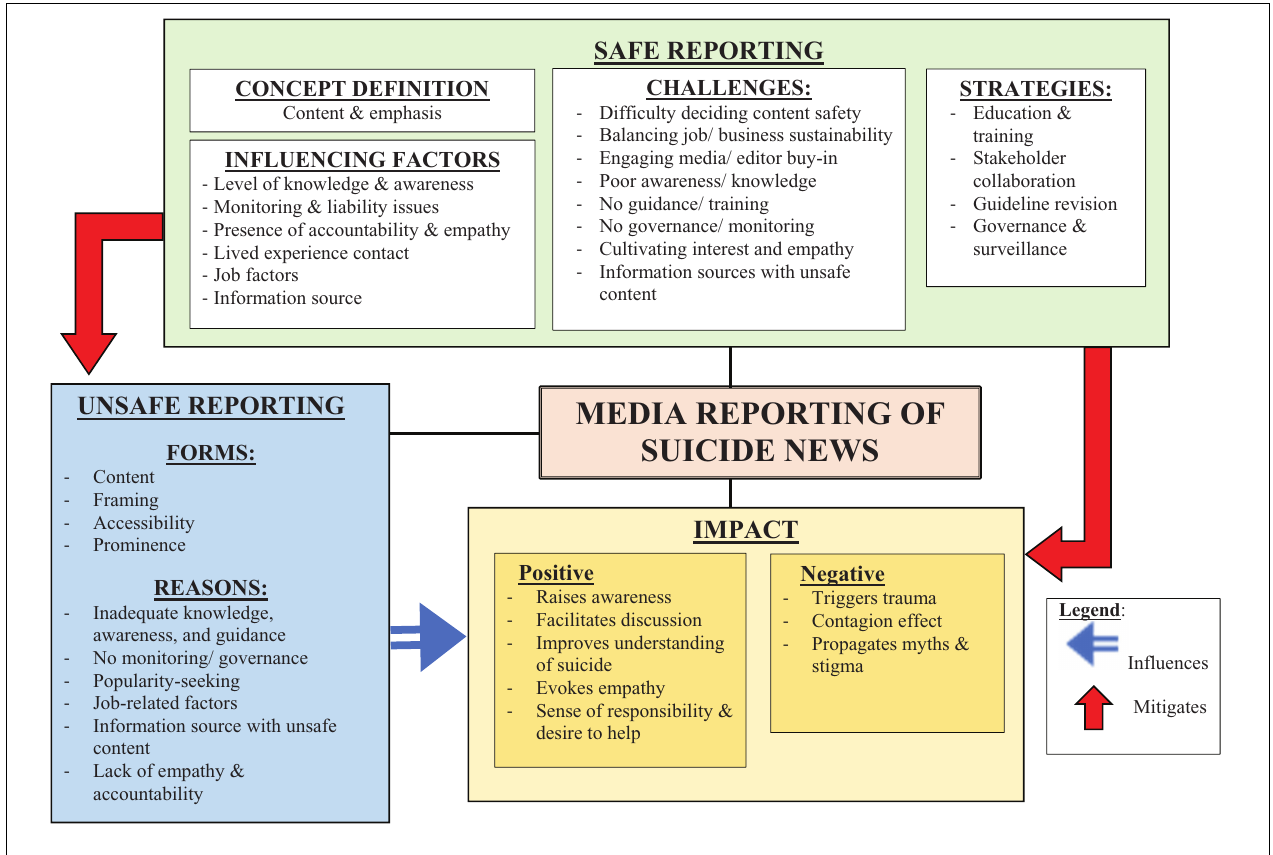
FIGURE 1 | Thematic